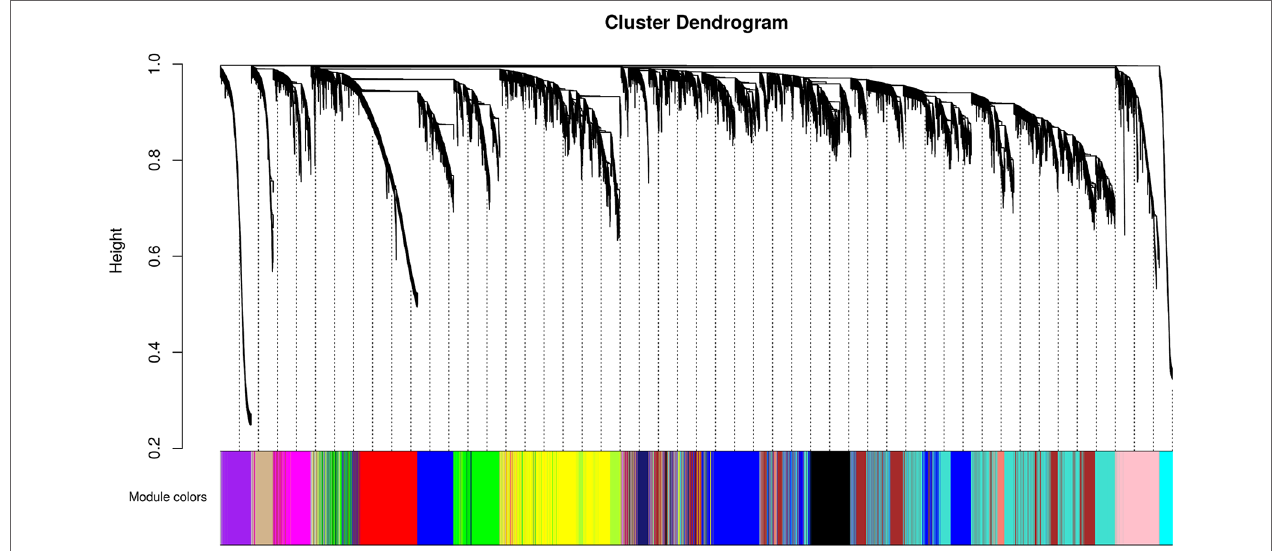
FIGURE 7 | Identification of gene co-expression modules among the different RNA-seq libraries analyzed with the WGCNA tool. Gene hierarchical cluster dendrogram based on a dissimilarity measure of the Topological Overlap Matrix (1 – TOM) calculated by WGCNA, together with the 15 assigned module colors.